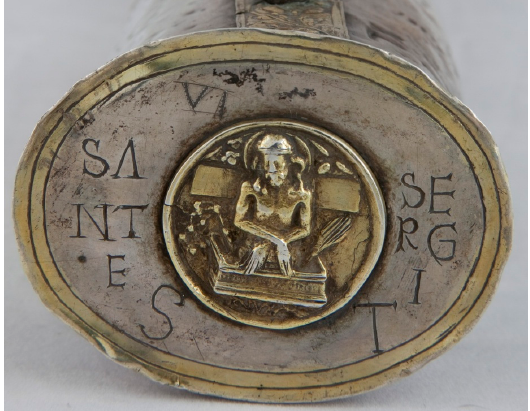
Figure 7. Bottom of an arm-shaped reliquary, 15th century, Cathedral of Saint Tryphon, Kotor, photo by Stevan Kordi ć .